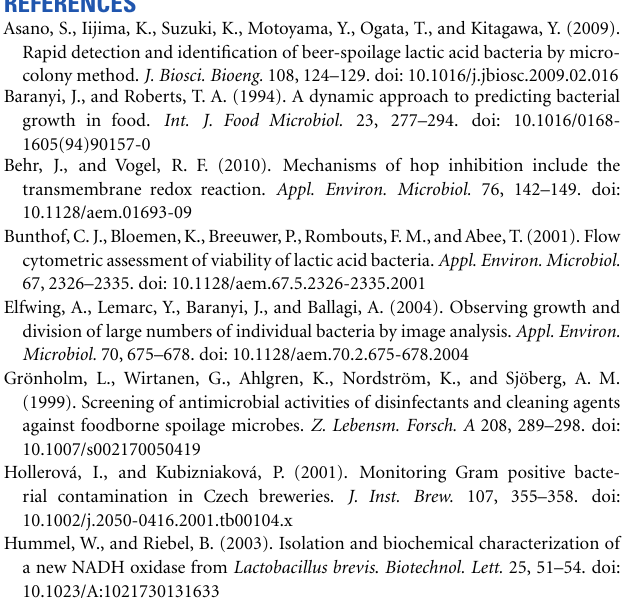
rate that is predicted by the initial divisions, even though PAA has been removed. This result is inconsistent with the results from Kutalik et al. (2005), which points out that the extent of the lag phase only influence the first cell cycle and the subsequent divi- sion is uncorrelated to the cell history. In addition, we found that the lag time was significantly shorter and the μ max was distinctly higher after the aerobic cultivation for both strains ( Figure 5